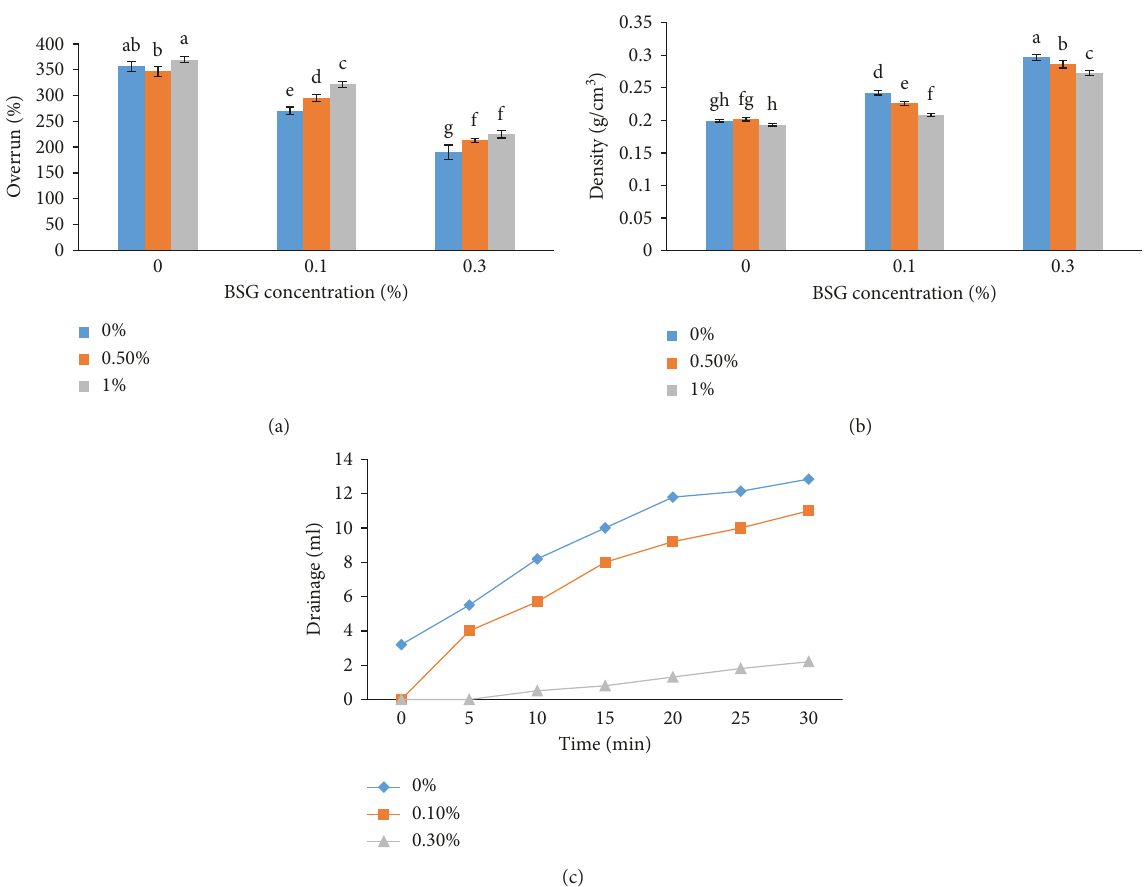
Figure 1: Effect of NaCl and basil seed gum concentration on overrun (a) and density (b) of egg albumin foams in the absence and presence of basil seed gum, as well as the effect of basil seed gum on foam stability in the absence of NaCl (c). Columns with different letters are significantly ( p < 0 . 05)